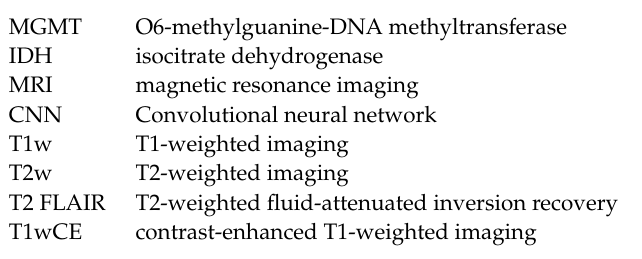
Figure S3: The distribution of ( a ) randomly generated prediction AUROC scores, and ( b ) private LB scores. Note that there is no difference between the two distributions, and AUROC of 1st place solution (0.621) can be reached in top 0.13% in the distribution of the randomly generated predictions (adopted from the BraTS 2021 challenge forum [37]). Figure S4: Shakeup plots of ( a ) ranks and ( b ) AUROCs obtained from public vs. private leader board of the BraTS 2021 challenge. Note that none of the submitted models show good ranks and AUROCs in both the public and private LB, but Table S1: MRI scan